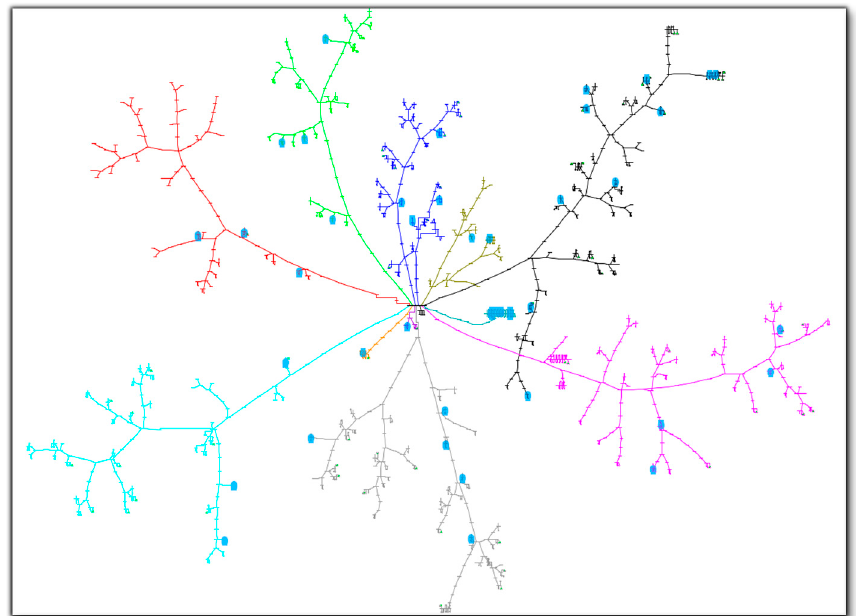
Figure A7. Use case 4—Location of PVs.